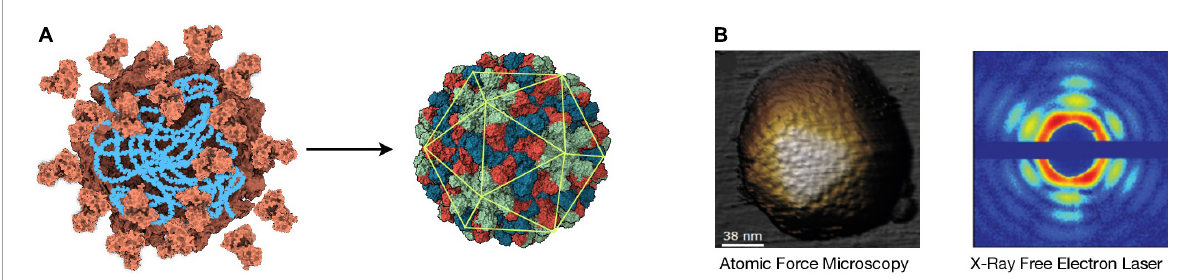
FIGURE3 Icosahedral Symmetry Formation and Detection. (A) Left: Cartoon representing the assembly of identical capsid protein subunits (orange) around a nucleic acid (blue). Right: The resulting virion has icosahedral symmetry, as indicated by the overlapping icosahedron (green). The different colors represent the three different positions that the subunits can occupy in this T = 3 structure that corresponds to the plant-infecting RNA virus TBSV (pdb: 2TBV). In this case, a capsid is assembled from 180 copies of the capsid protein. The structural data were downloaded from RCSB Protein Data Bank and visualized with UCSF ChimeraX. (B) Left: Image of an adenovirus particle detected by atomic force microscopy (AFM) [adapted from de Pablo and San Martín (2022)]. Right: X-ray diffraction pattern caused by a mimivirus particle using X-ray free-electron laser (XFEL) [adapted from Ekeberg et al.